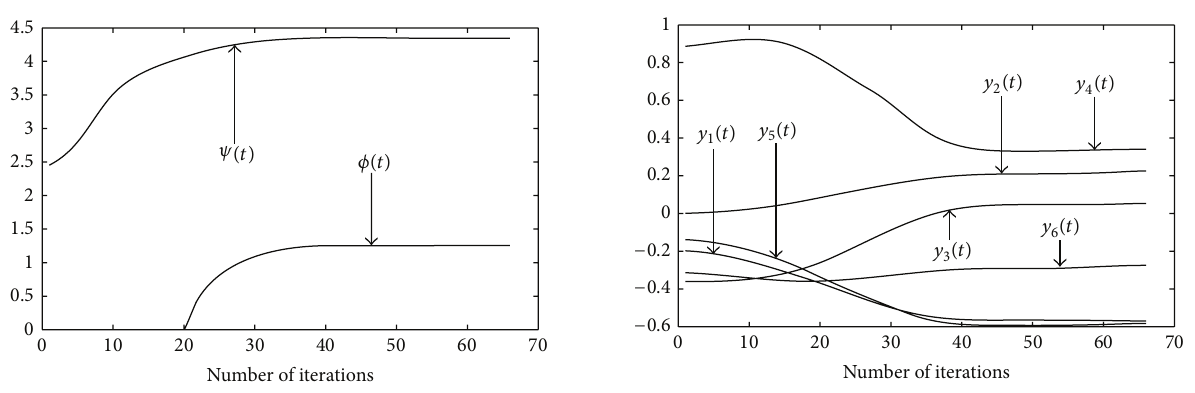
Figure 7: Trajectories of 𝜓(𝑡) = 𝑥(𝑡) 𝑇 (𝐴 + 𝐴 𝑇 )𝑥(𝑡)/2𝑥(𝑡) 𝑇 𝑥(𝑡) and 𝜙(𝑡) = √(𝑥(𝑡) 𝑇 (𝐴𝐴 𝑇 )𝑥(𝑡)/𝑥(𝑡) 𝑇 𝑥(𝑡)) − 𝑎 2 𝑥(0) as (55), which should converge to 𝑎